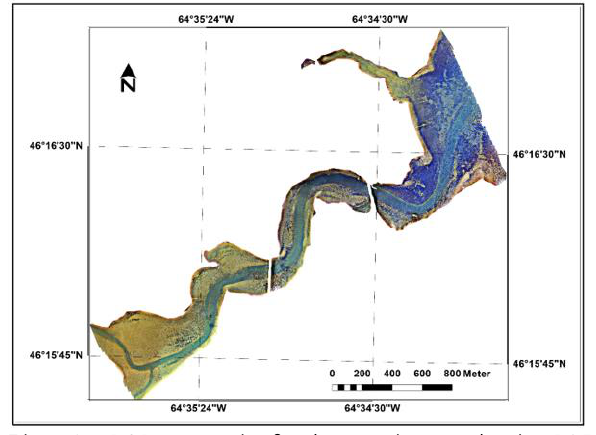
Figure 3. RGB composite for the mosaic created using PCI Geomatica with the images acquired over Shediac Bay on August 31st, 2018.